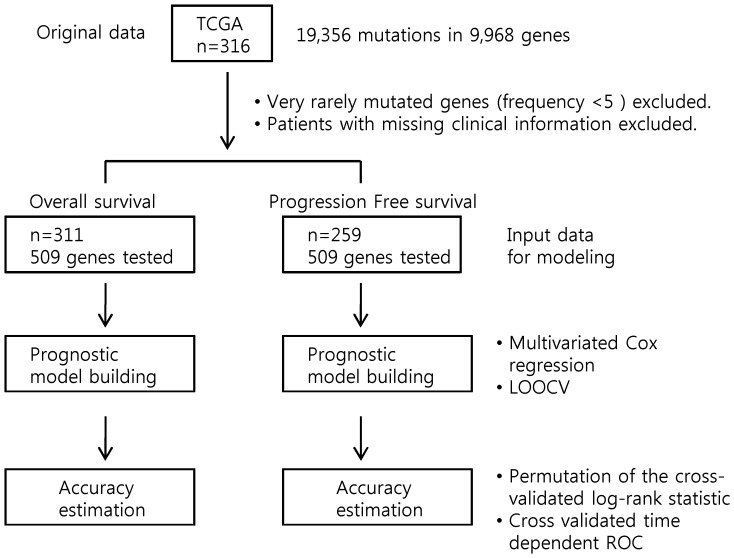
Workflow of prognostic model building using somatic mutation profile in ovarian high-grade serous carcinoma.